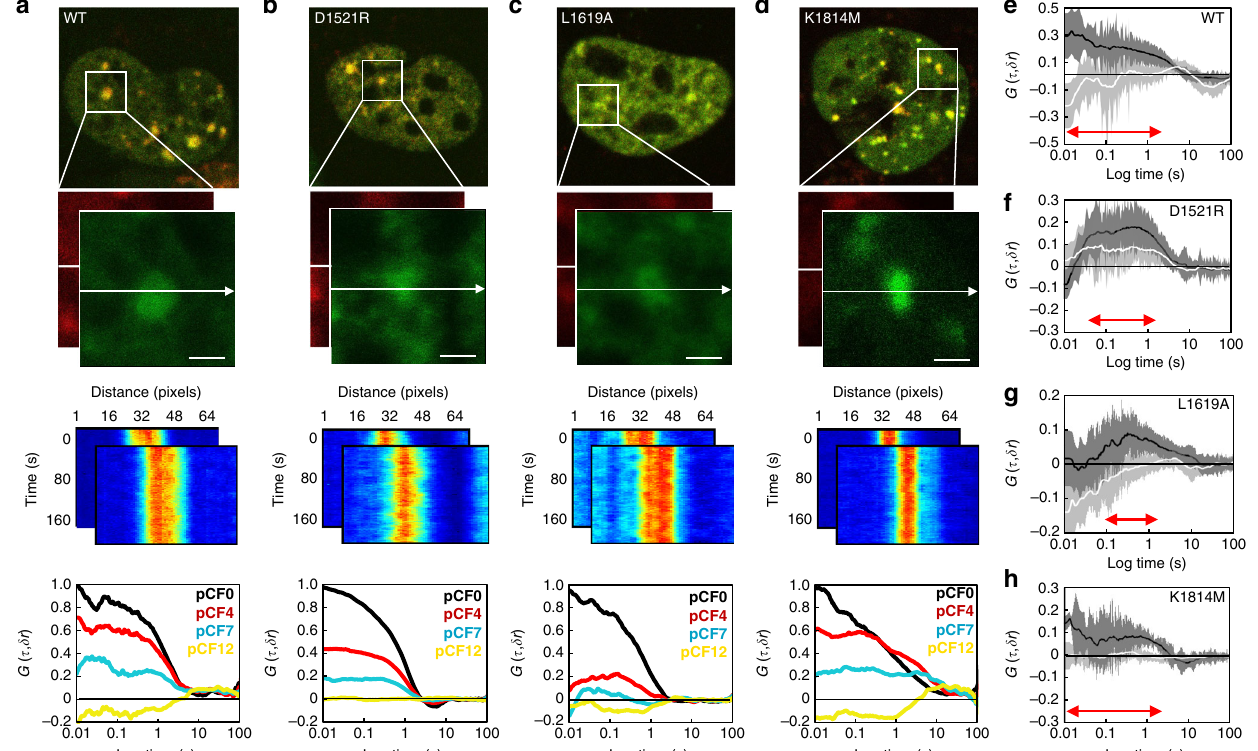
Fig. 5 The DSB histone code differentially regulates 53BP1 dimer transportation and retention onto a DSB. a – d Two color merged confocal image of a DIvA cell nucleus co-transfected with eGFP and mKate2 tagged 53BP1 (WT) ( a ), 53BP1 D1521R (D1521R) ( b ), 53BP1 L1619A (L1619A) ( c ), and 53BP1 K1814M (K1814M) ( d ), which has been treated with 4OHT for 60 min (top row) and the region of interest selected for acquisition of a two-channel line scan (second row). Intensity carpet of the two-channel line scan acquired across a selected 53BP1 WT, D1521R, L1619A and K1814M foci in the green and red channels (third row), as well as cross-pCF analysis of the spatial evolution of 53BP1 WT, D1521R, L1619A, and K1814M dimer transport onto this structure at a distance of δ r = 0, 4, 7, and 12 pixels (i.e., pCF0, pCF4, pCF7, and pCF12) (bottom row). In agreement with cross-pCF analysis of 53BP1 WT in Fig. 3, cross-pCF7 was optimal for tracking D1521R, L1619A, and K1814M dimer translocation onto the DSB foci (cross-pCF4 tracks local mobility while pCF12 does not detect 53BP1 dimer translocation with signi fi cant ef fi ciency). e – h Cross-pCF7 analysis of 53BP1 WT ( e ), D1521R (f), L1619A ( g ), and K1814M ( h ) dimer translocation onto a DSB foci (black) vs. off this nuclear structure (white) ( N = 10 cells, two biological replicates). Shading indicates SEM and red arrows indicate in each case the distribution of time delays detected. All cross-pCF curves in a – d and e – h are normalized with respect to cross pCF0. Scale bars, 2 μ